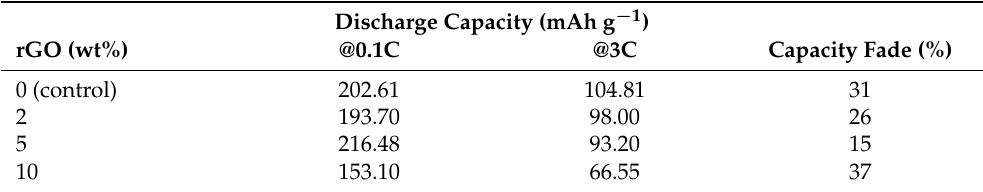
Table 1. Optimization study for selecting the percentage of reduced graphene oxide (rGO) additive for rGO/NMC811 batteries to operate in a high-voltage window of 2.5–4.5 V. The capacity fade was calculated after 100